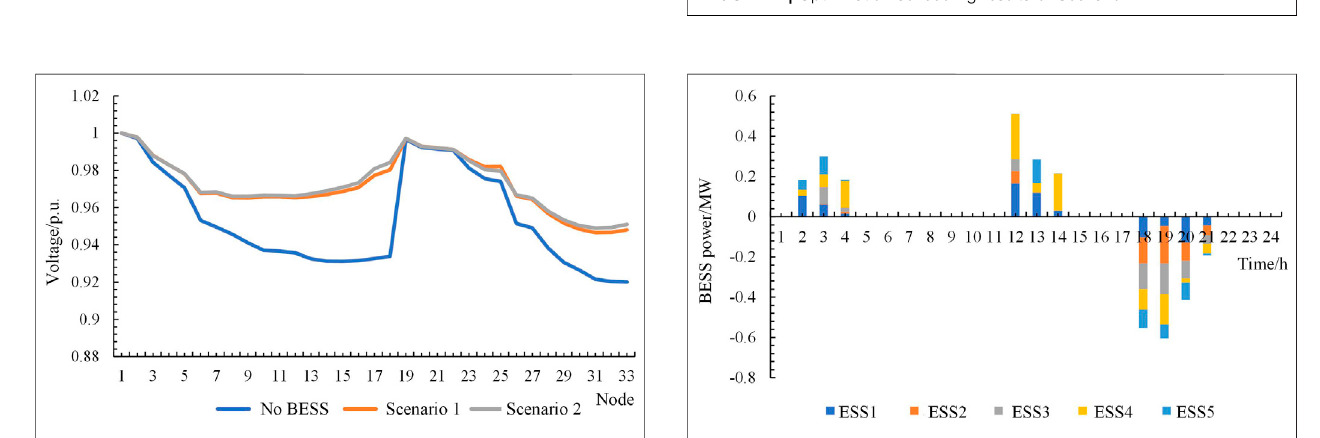
FIGURE 7 | Optimization scheduling results of Scenario 1.